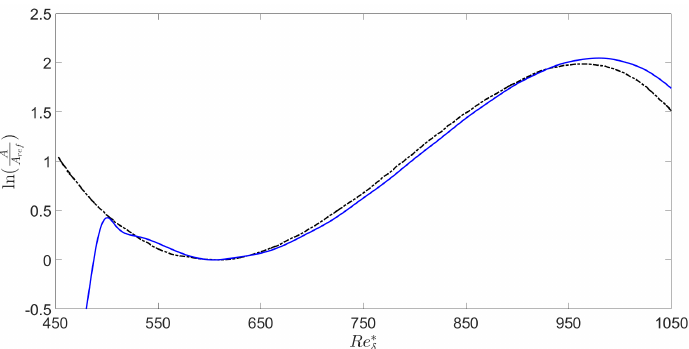
Figure 5. Amplification curves; A ref is evaluated at the Branch I location, Re δ ∗ = 605. 2D DNS; Fasel & Konzelmann